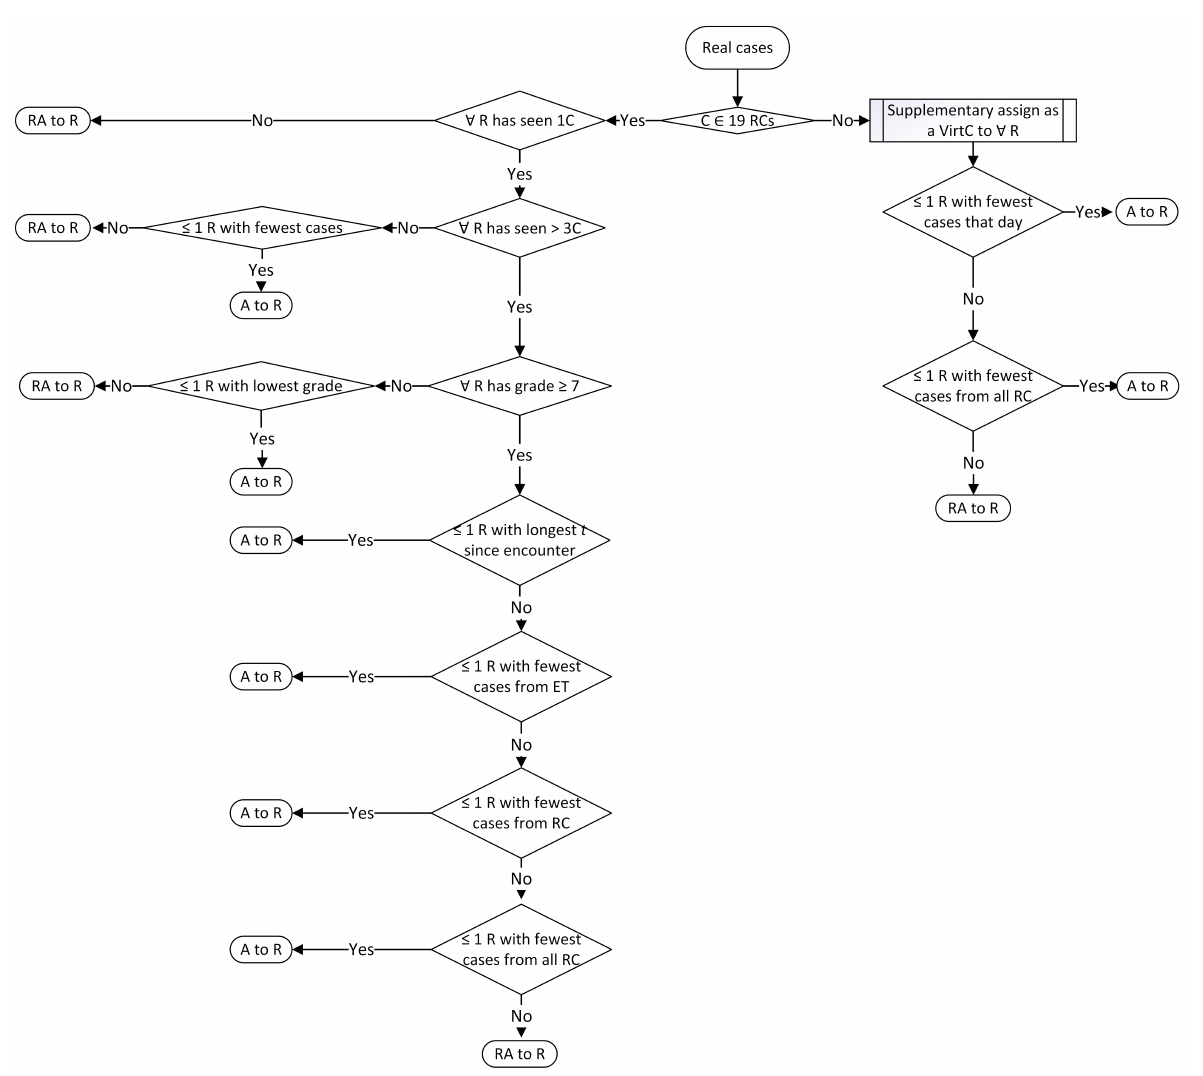
Figure A1. Rules for assigning real cases (A = assign; C = case; ET = educational topic; R = resident; RA = randomly assign; RCs = retinal conditions; RealC = real Cases; t = time; VirtC = virtual